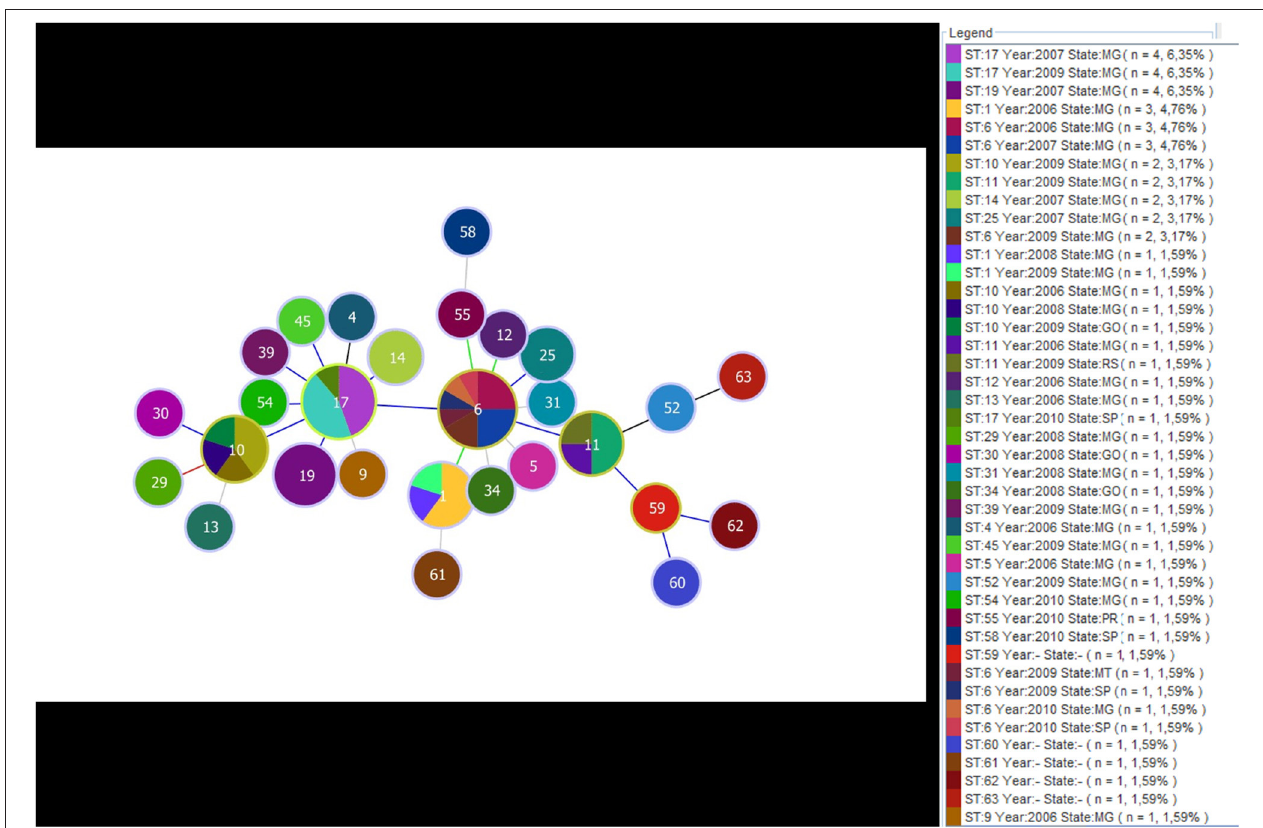
FIGURE 2 | Minimum spanning tree exhibiting the formation of clonal complexes according to genotypic profiles obtained by the multi sequence typing of Mycobacterium bovis . Distribution of 58 samples of M. bovis isolated from the years 2006 to 2010, four standard samples of M. bovis (CR01, CR02, CR13, and CR36) and the strain M. bovis (AF2122/97). The dendrogram reveals the formation of five clonal complexes ST6, ST10, ST11, ST17, and ST59 that formed from the comparison of 28 ST. In the subtitle “N” figure indicates the number of isolates with the same genotypic profile, as well as the size of the circles (the larger the circle, the larger the population represented). Circles with more than one color profile indicate the same genotype isolated from different regions and year of isolation of the